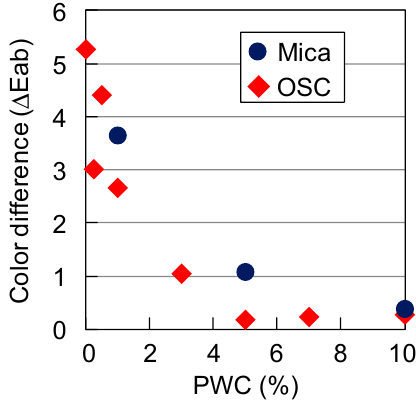
Figure 4. Measured Δ E between the cell region and backsheet region as a function of PWC.